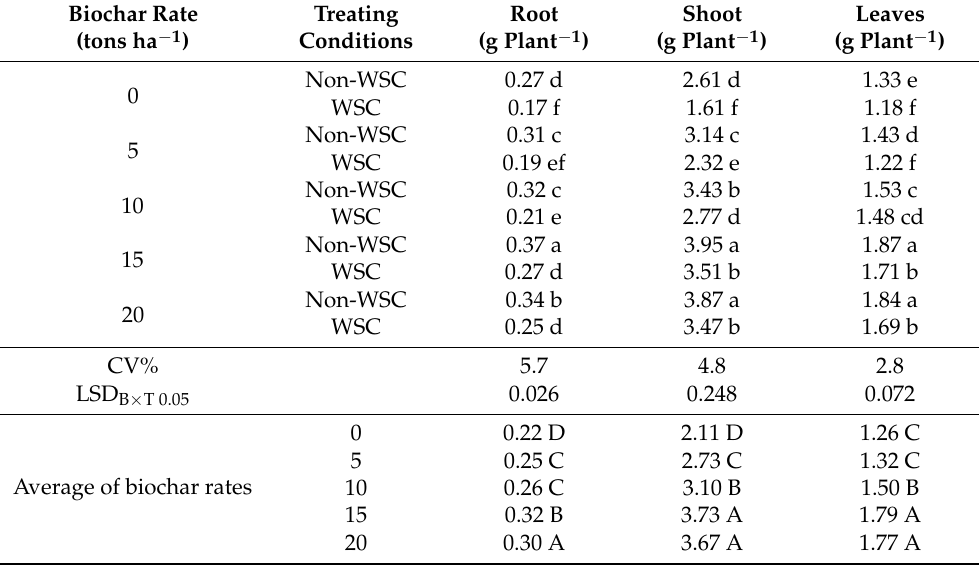
Table 4. Effect of biochar on dry weight of Ehretia asperula under non-WSC and